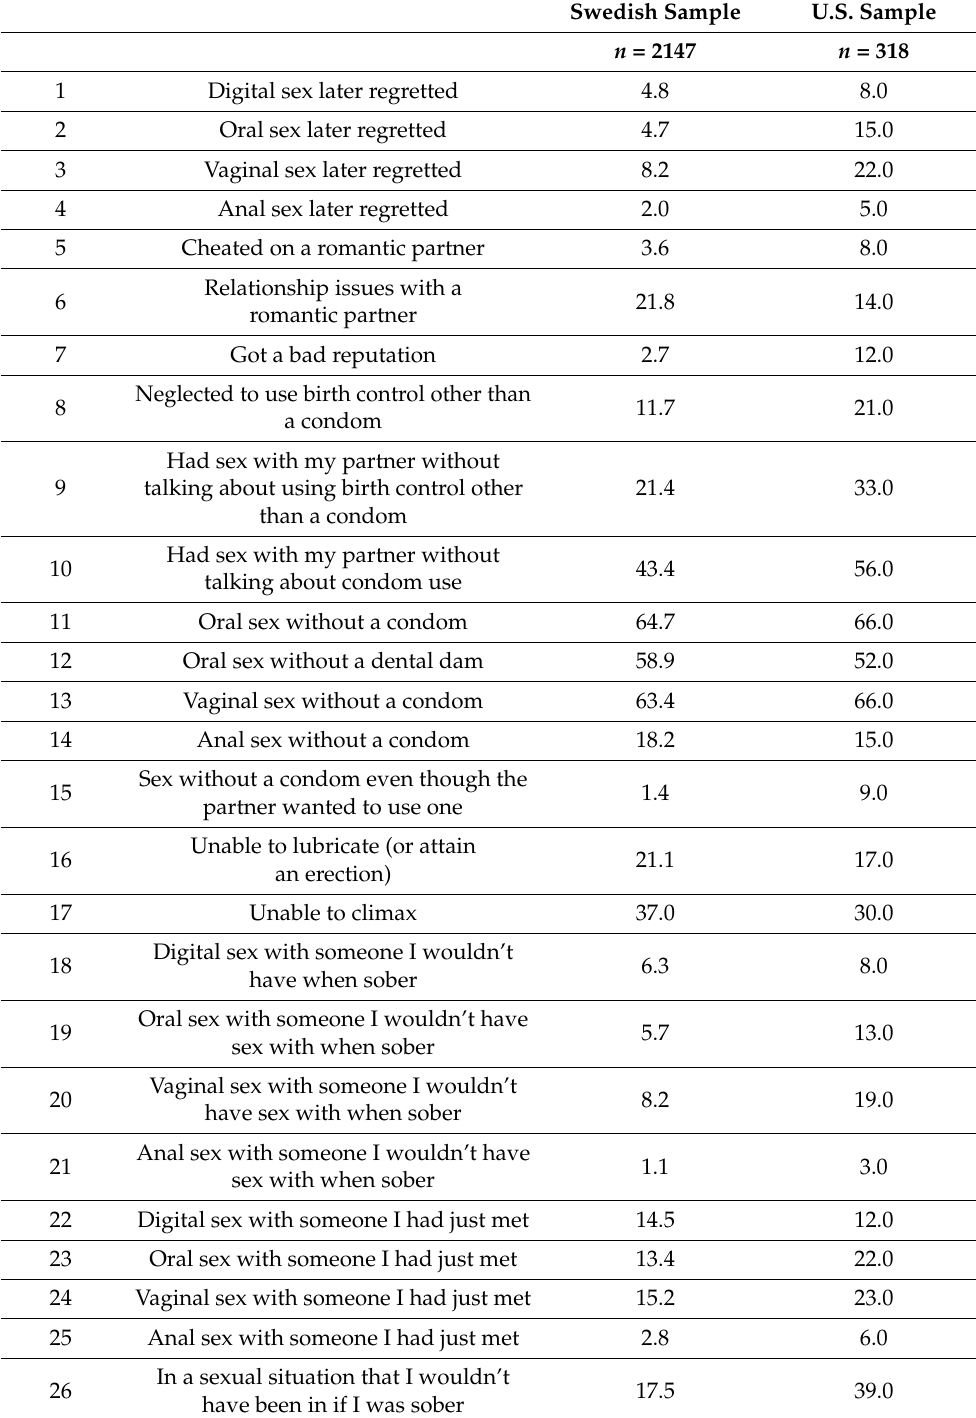
Table A2. A comparison of alcohol-related sexual consequences reported during the past three months in Sweden and alcohol-related sexual consequences reported during the past month in the U.S. study that was conducted by Fairlie et al.